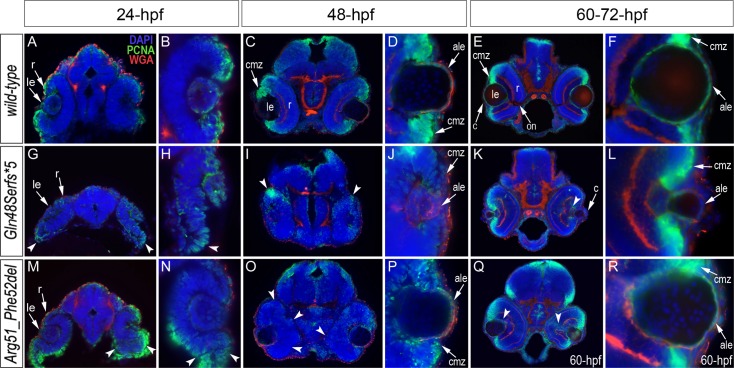
Analysis of proliferation patterns and differentiation markers in wild-type and mutant embryos.Immunostaining with PCNA (Proliferating Cell Nuclear Antigen) (green), DAPI (blue), wheat germ agglutinin (WGA) (red) was performed using 24–72-hpf wild-type embryos (A-F) as well as mab21l2
Q48Sfs*5 (G-L) and mab21l2
R51_F52del (M-R) mutant tissues. Embryonic stages are indicated above; overlay fluorescence images are shown and single immunoreactivity data is available in S4 Fig. White arrowheads point to defects in retinal invagination and regions of abnormal retinal folding (H,M,N) observed in both mab21l2
Q48Sfs*5 and mab21l2
R51_F52del embryos (please see text), as well as areas of aberrant PCNA labeling (I,K,O,Q). Please also note the absence of PCNA staining in the anterior lens epithelium of 48- and 72-hpf mab21l2
Q48Sfs*5 mutants (J,L). ale, anterior lens epithelium; c, cornea; cmz, ciliary marginal zone; le, lens; on, optic nerve; r, retina.